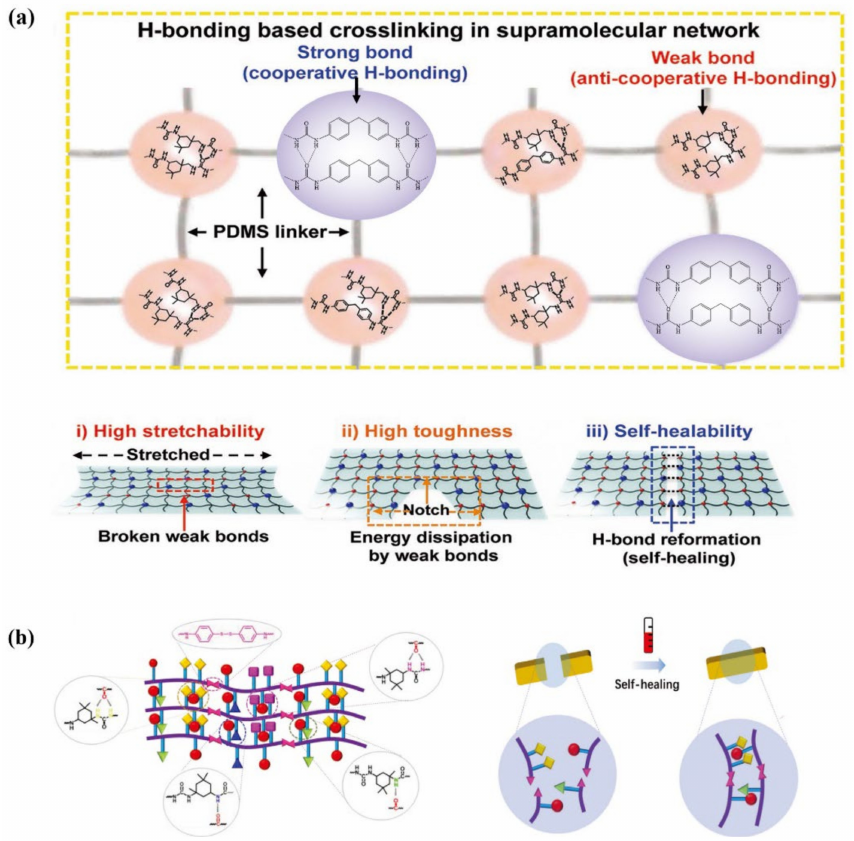
Figure 3. ( a ) Possible hydrogen bonding combinations for strong bond and weak bond, respectively, and schematics of a stretched polymer film (i), notched film (ii), and healed film (iii). ( b ) Schematic dia- grams of ideal elastomer structure and self-healing mechanism. Reproduced with permission